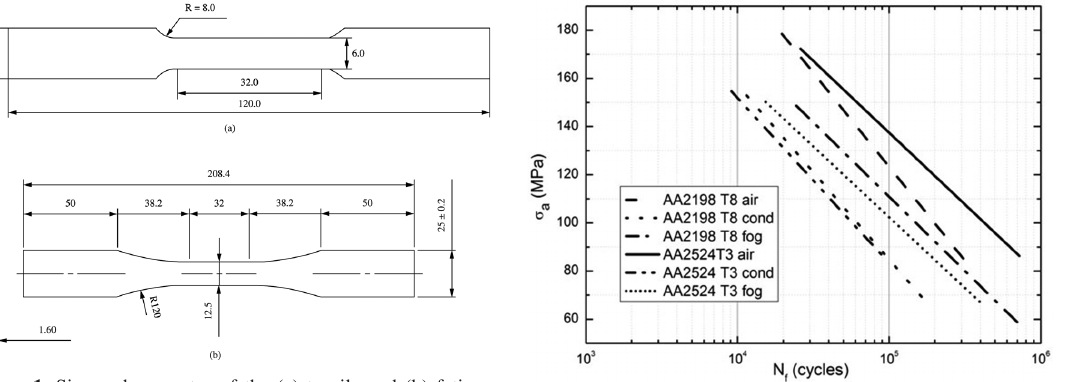
Figure 3. Comparison of S-N curves of AA2524-T3 and AA2198-T851 aluminum alloys in tested under different environments and specimens